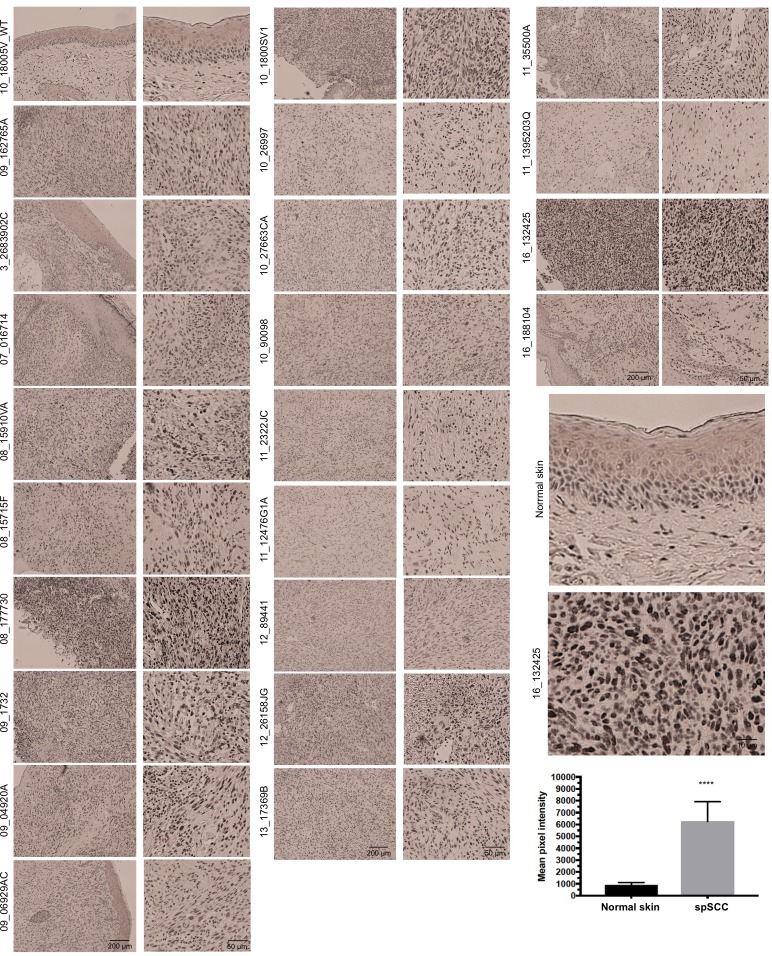
A panel of human spSCC tumours are characterised by widespread nuclear Zeb1 localisation.